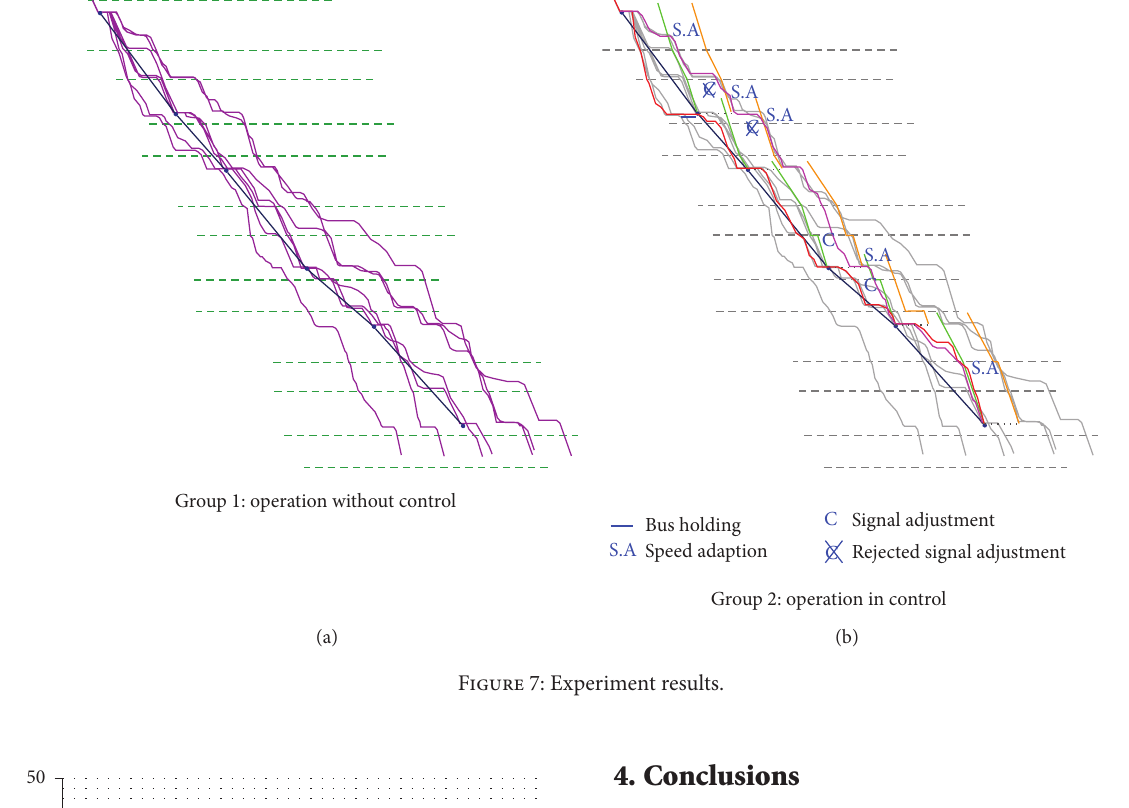
Figure 7: Experiment results.